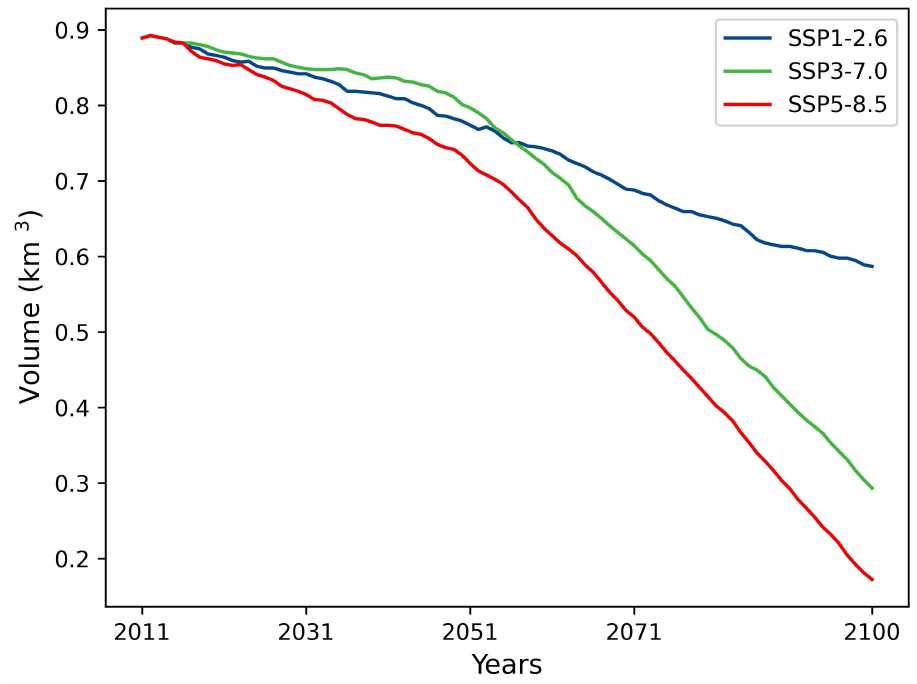
Figure 9. The volume time series of JMYZG under different climate